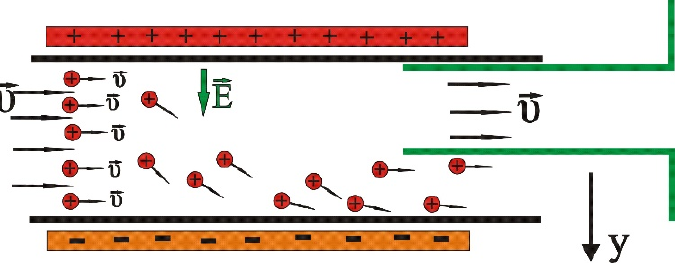
Figure 3. Configuration of heavy metal ion movement through the duct.